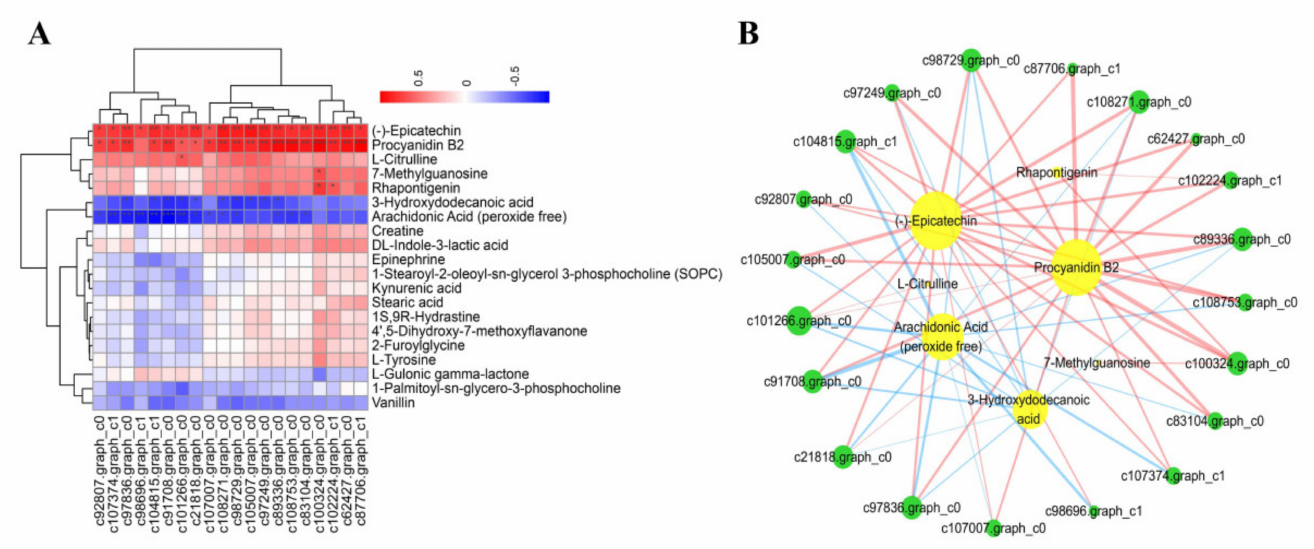
Figure 5. Analysis of the correlation between the changes in levels of DEGs and DAMs. ( A ) Correla- tion heat map. Asterisks in the panels represent the significance of the correlation, with p -values of less than 0.001 (***), less than 0.01 (**), and less than 0.05 (*). ( B ) Associated network diagram created using Cytoscape. Lines colored in “red” and “blue” represent positive and negative correlations, yellow circles indicate metabolites and green circles indicate genes, p -value set at